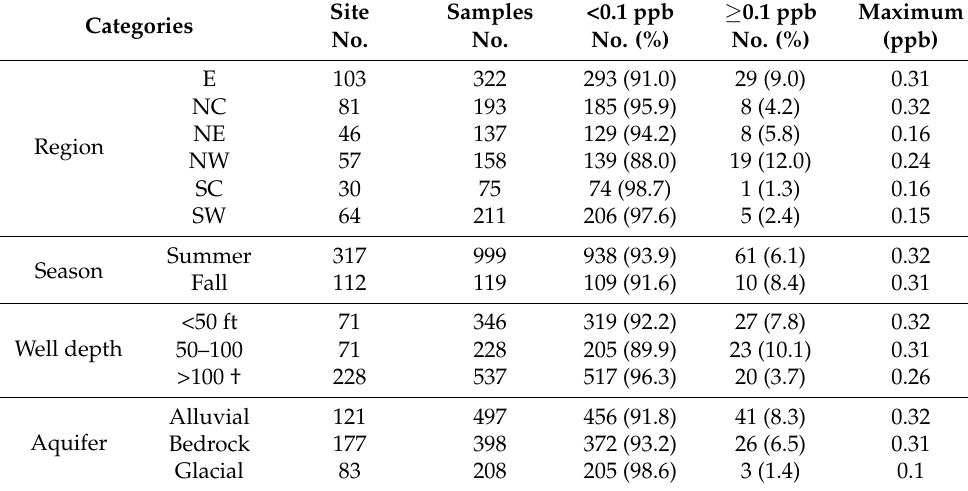
Table 6. Occurrence of DEA in Public